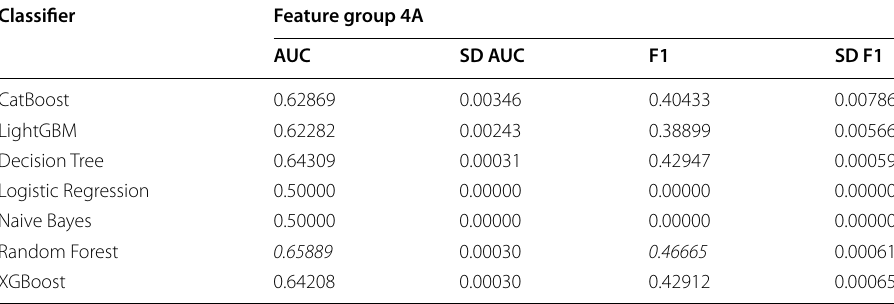
Best metrics are highlighted in italics; SD AUC is the standard deviation of AUC and SD F1 is the standard deviation of the F1-score Table 29 Mean performance of 7 classifiers in terms of AUC and F1-score on datasets with features from feature group all features A